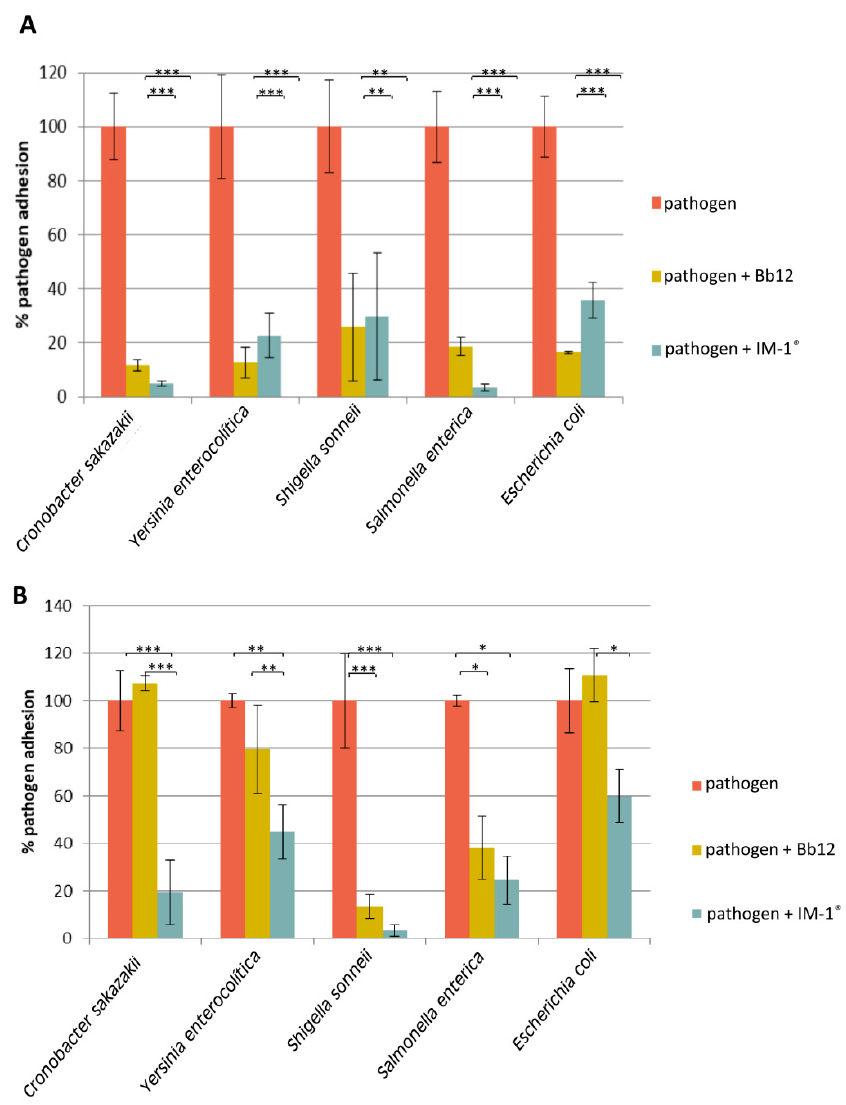
Figure 4. Retained pathogen adhered to HT29 cells after subsequent displacement by exposition to B. infantis IM-1 ® cells ( A ); and pathogen adhesion to HT29 cells previously exposed to B. infantis IM-1 ® cells ( B ). The results were normalized considering 100% the adhesion of the pathogen in the absence of bifidobacterial treatment. The strain B. animalis subsp. lactis Bb12 was used as a reference for comparative purposes. For each pathogen, the three treatment groups were compared to get statistical significance by using ANOVA tests, followed by Tukey pairwise test comparison (*** p < 0.001, ** p < 0.01, * p <